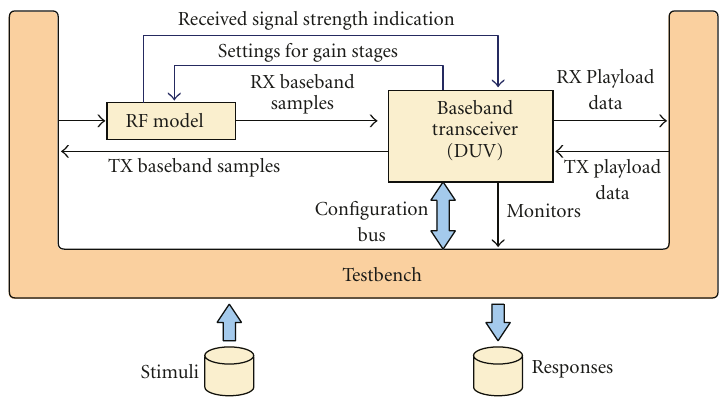
Figure 4: Testbench